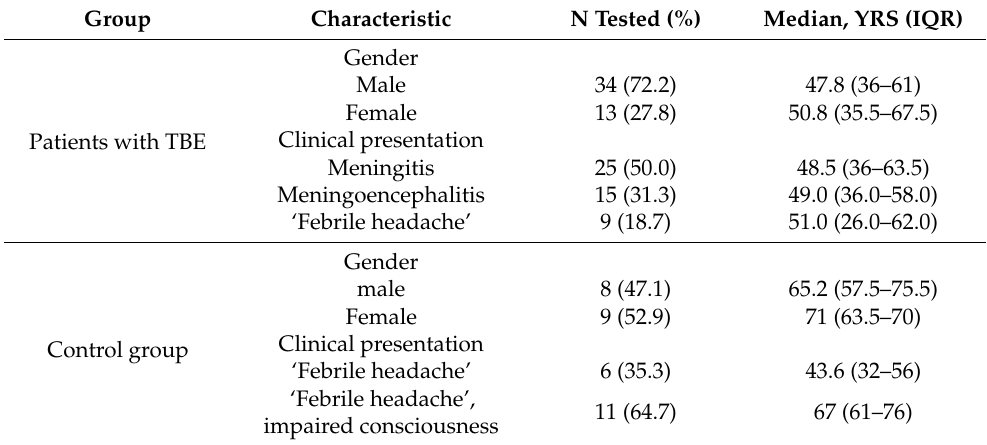
Table 1. Demographic structure and clinical characteristics of patients with TBE and control group.